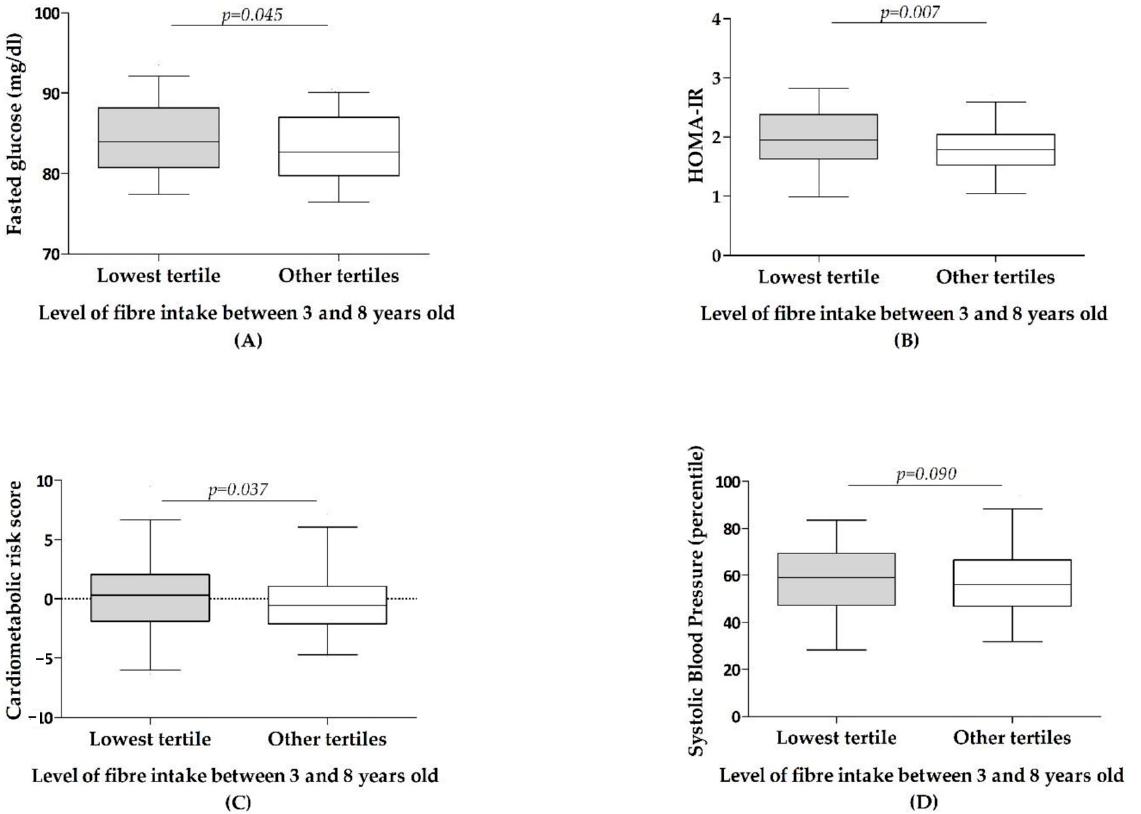
Figure 1. Cardiovascular health parameters according to the level of fibre intake throughout childhood. Children classified as being repeatedly in the lowest tertile of fibre intake between 3 and 8 years old (at least three times out of five in this period) or in other tertiles and/or not repeatedly in the lowest tertile. Results from one-way ANOVA models adjusted by country, sex, body mass index and maternal education for glucose ( A ), HOMA-IR ( B ), Cardiometabolic risk ( C ) and systolic blood pressure ( D